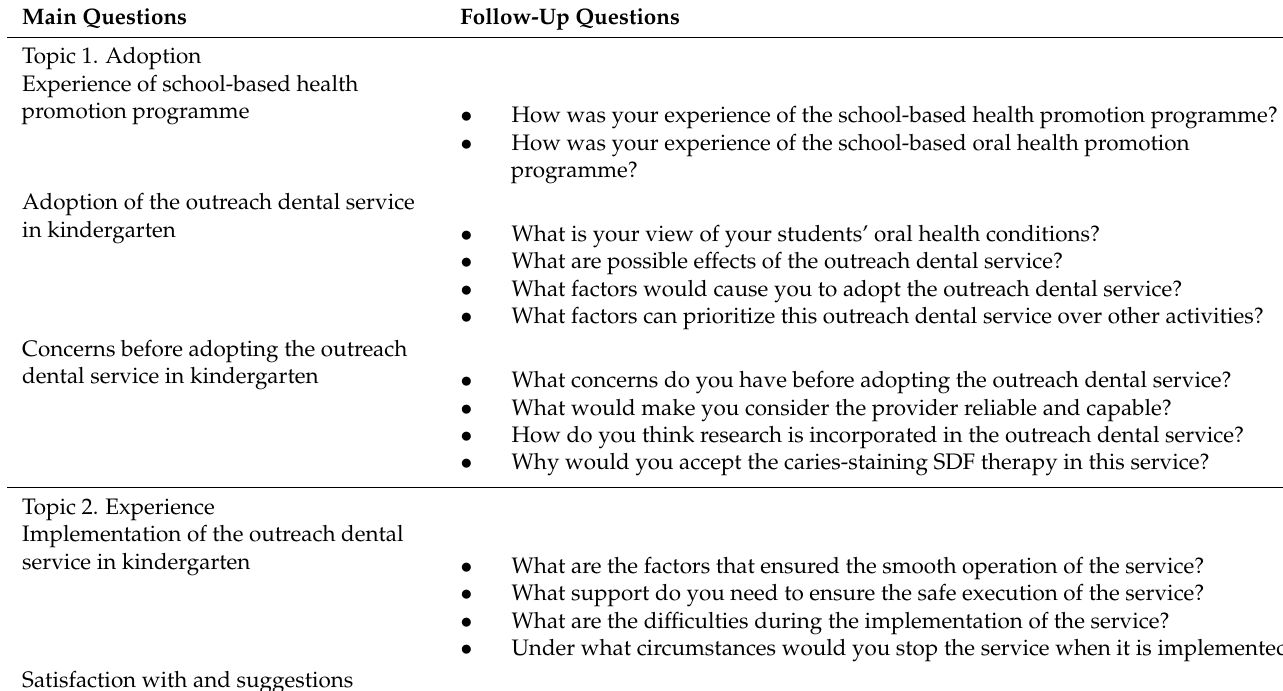
Table 1. Main and follow-up questions of the two topics in the semi-structured